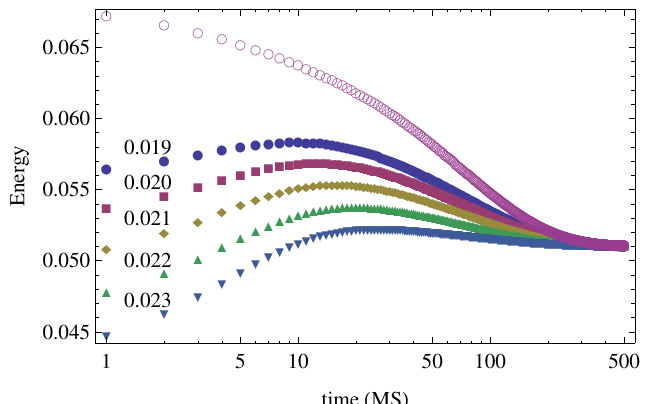
Figure 7. Memory effect at the evolution of the open cluster ( h (cid:48) = 1) energy at T = 0.18 after the jump from the equilibrium state at T = 0.19 (open circles) and after double-jumps from T = 0.19 with an isothermal period for 200 MS at temperatures between T = 0.019 and T =